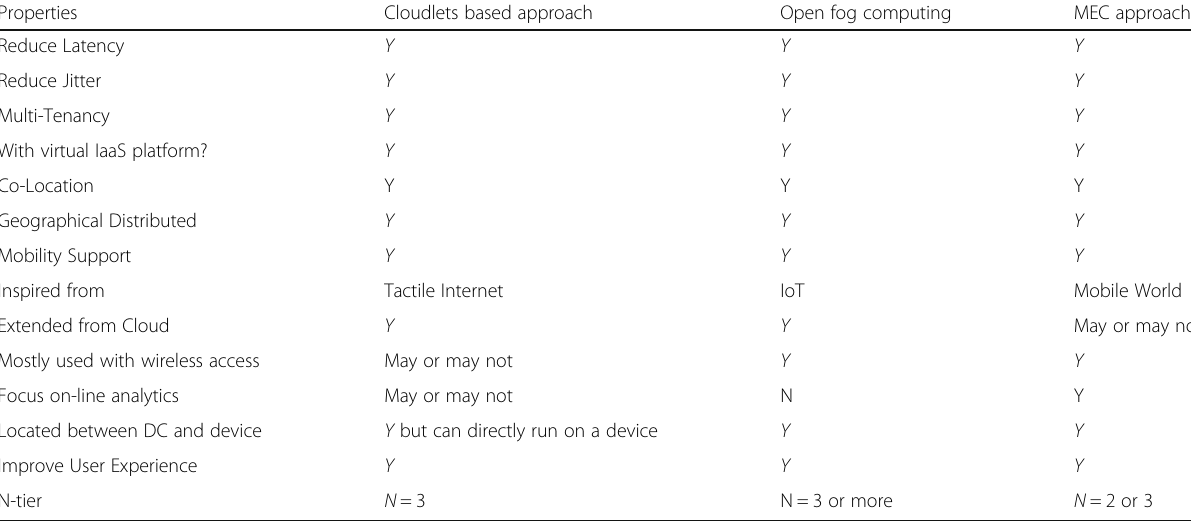
Table 1 Comparison of cloudlets, fog and MEC approaches [35]